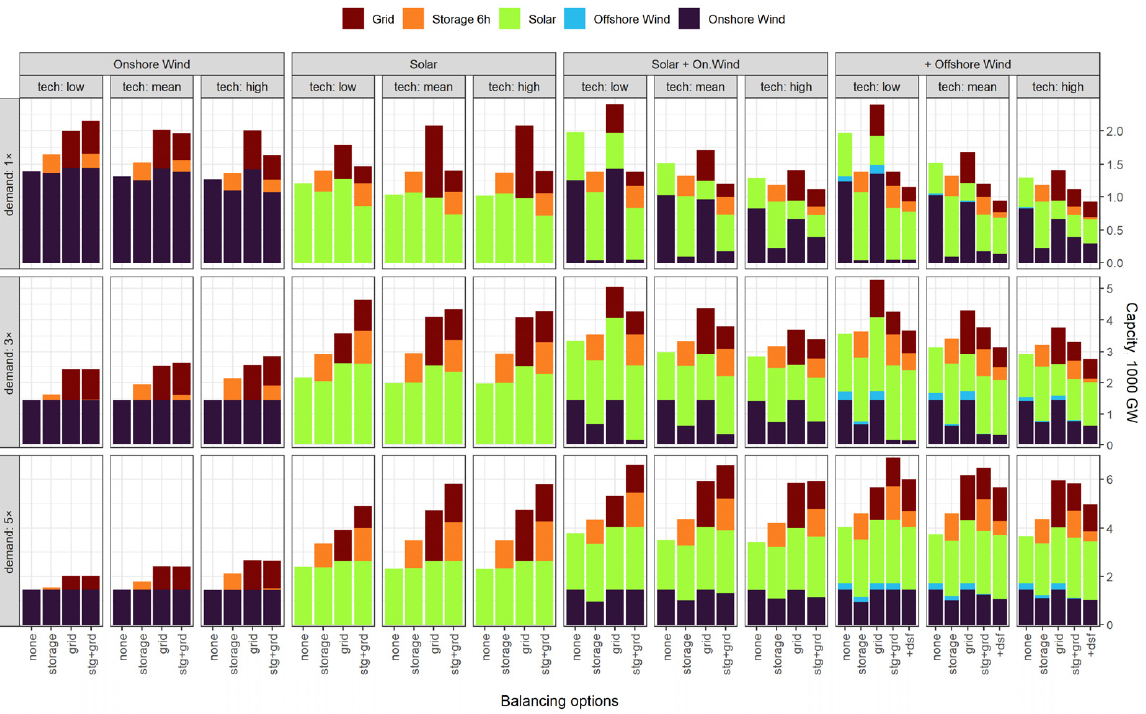
Figure 5. Electric power sector generating and balancing capacity in 153 scenarios.